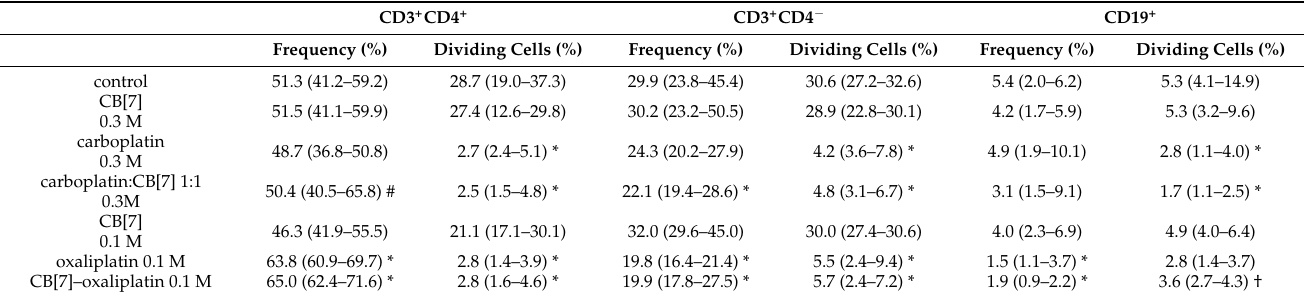
Table 2. The relative number and level of anti-CD3 stimulated proliferation of various subpopulations of PBMCs.